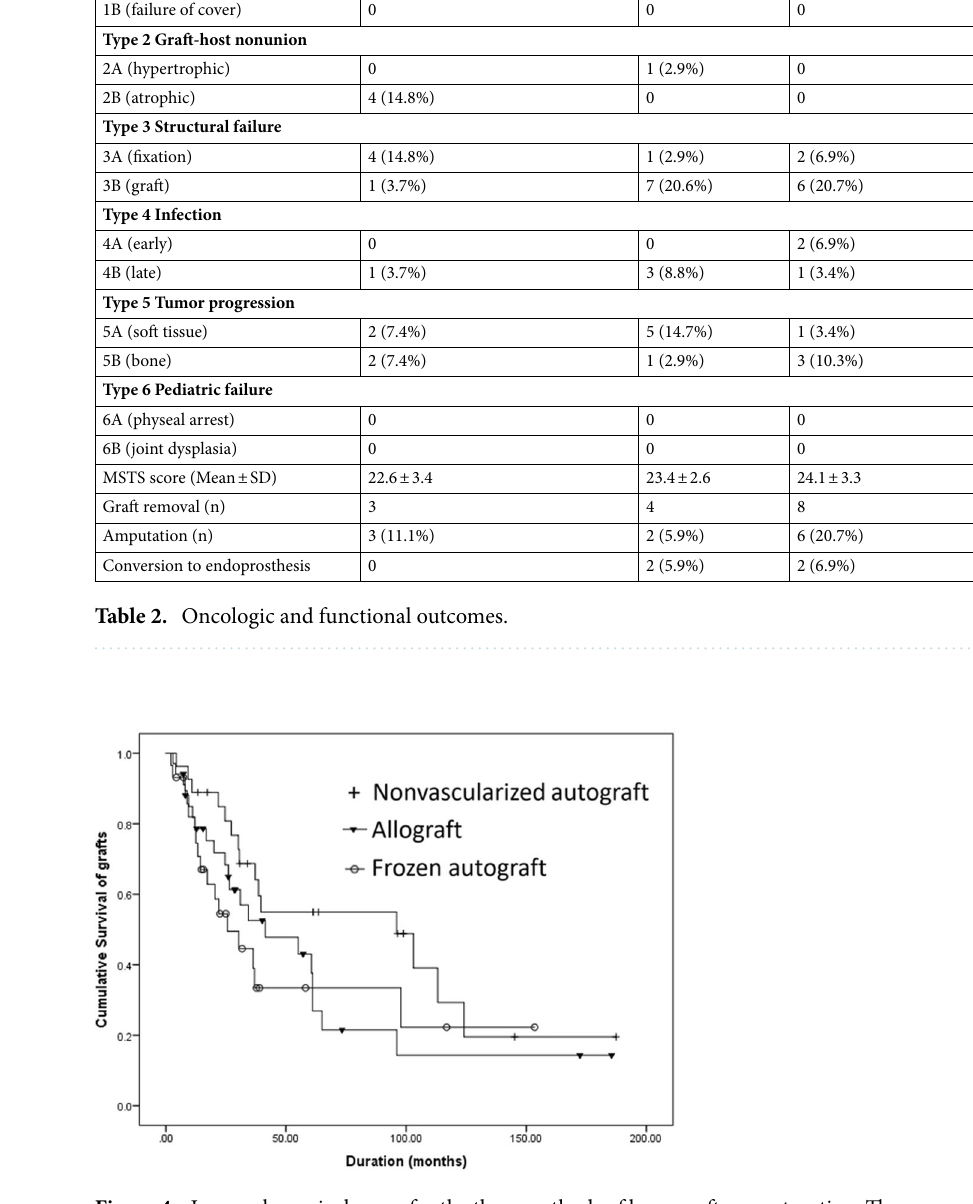
Figure 4. Log-rank survival curve for the three methods of bone graft reconstruction. There was no statistically significant difference between the nonvascularized autograft and recycled frozen autograft groups ( p = 0.08), the nonvascularized autograft and allograft groups ( p = 0.12), and the allograft and recycled frozen autograft groups ( p =